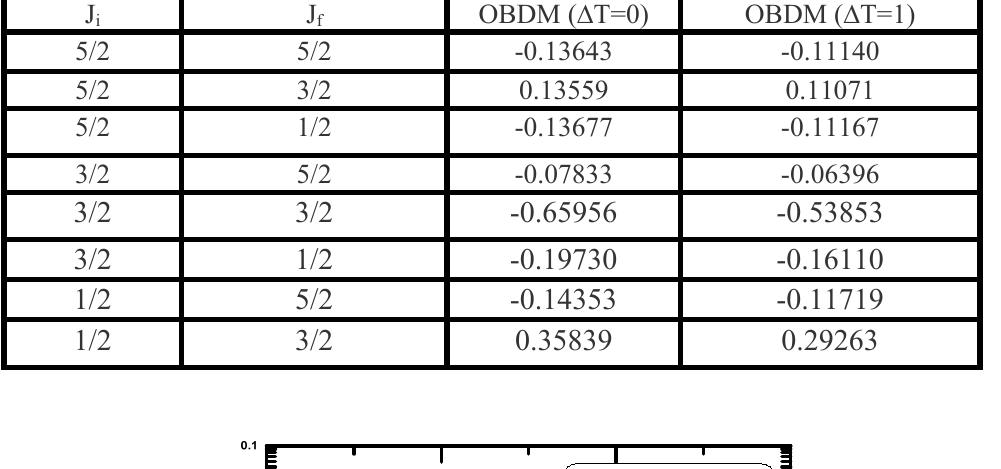
Table 2: The values of the OBDM elements for the longitudinal C2 transition of the 2 1, first state of 58 Ni using F5PVH model space effective interaction, with the residual interaction M3Y and Gogny at E =1.398 MeV. X